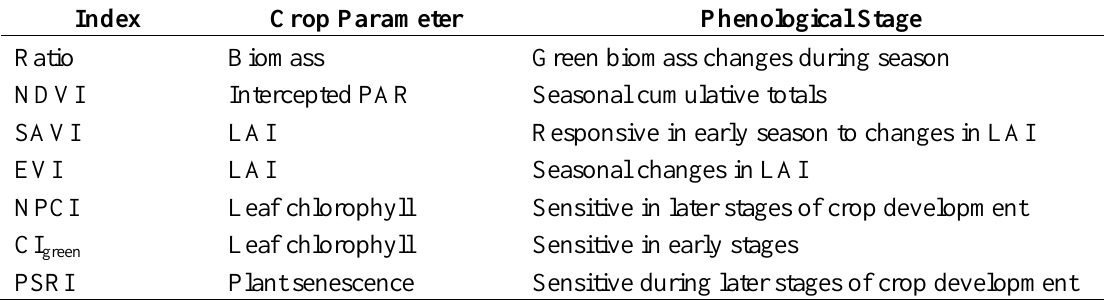
Table 6. Vegetative indices and their application to specific crop parameters and phenological stages of crop